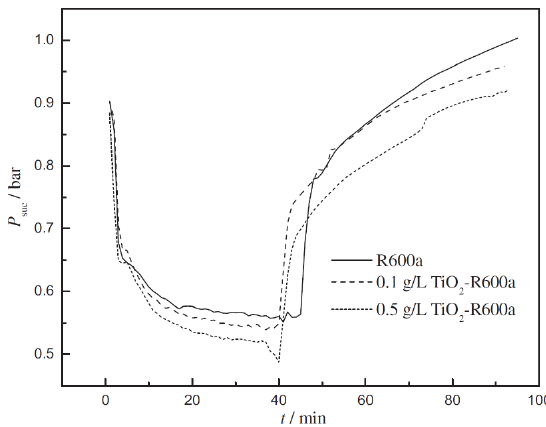
Figure 16. Compressor suction pressure [42]. Table 1. Energy consumption test results [42].